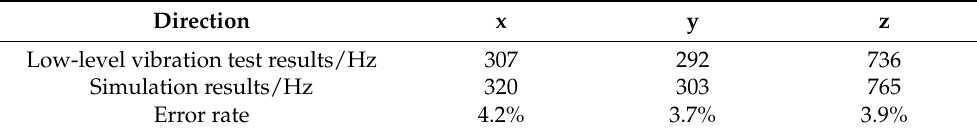
Figure 9. Vibration test on the vertical bracket. ( a ) Schematic diagram of vibration test. ( b ) Schematic diagram of three-way sensor. ( c ) X-direction swept test curve. ( d ) Y-direction swept test curve. ( e ) Z-direction swept test curve. Table 4. Comparison of small-scale characteristic sweep test results and simulation